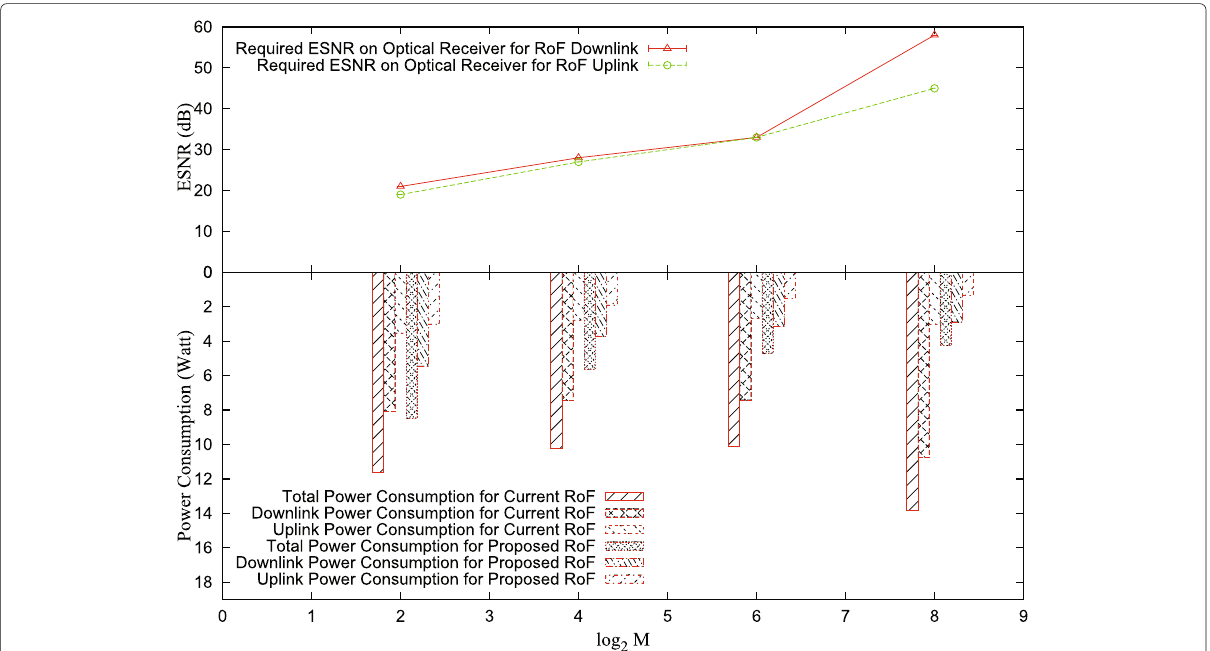
Fig. 4 Required ESNR on optical receiver and power consumption of RoF system for supporting a single BS with V π = 6.5 VS modulation